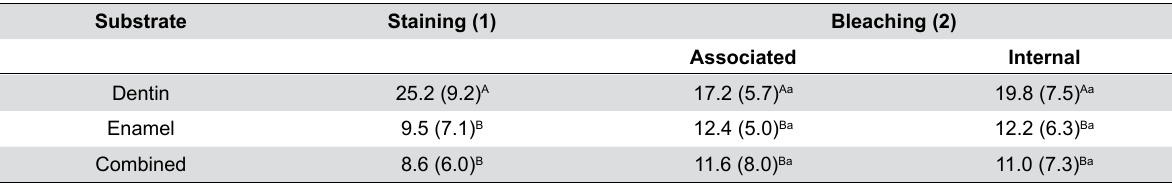
Figure 1- Schematic illustration of tissue recombination for measuring the contribution of tissues to color change (CTCC). A and B are the recombinations used to measure the effects of staining and bleaching procedures, respectively. Color data measured by the spectrophotometer were used to shade figures. Blocks upper color is that measured from combined specimens Table 1- Means (standard deviations) of ΔE00 according to substrate and bleaching technique (n = 10)